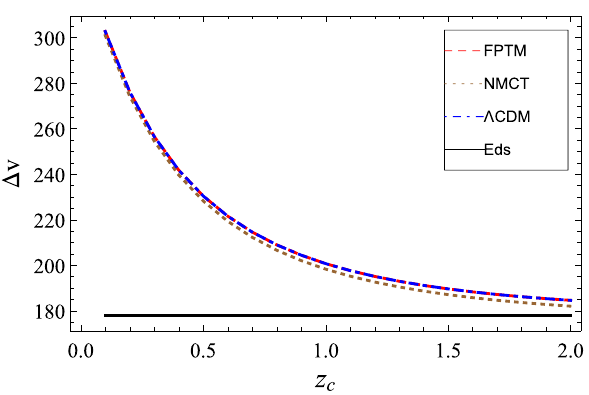
Fig. 14 The evolution of virialized overdensity parameter Δ V versus z c for the Λ CDM , FPTM, NMCT and Eds models